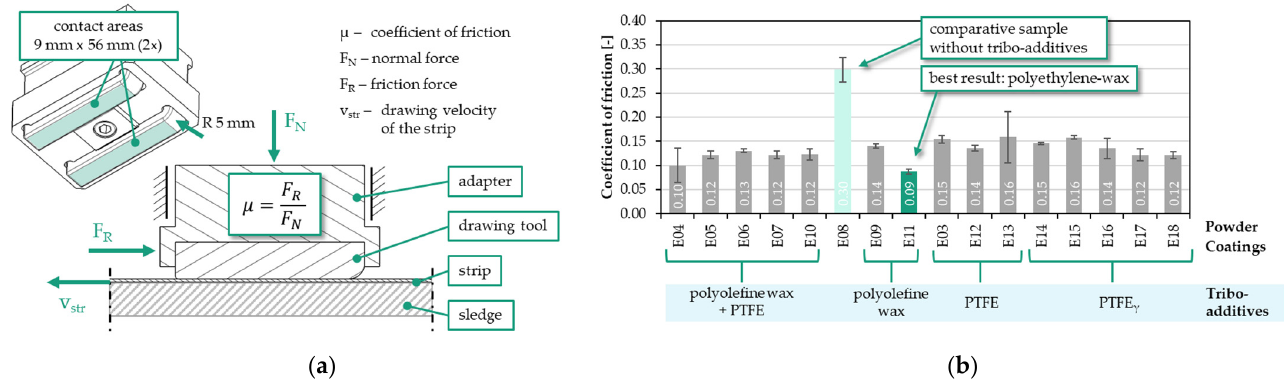
Figure 6. Flat strip drawing test for determination of the coefficient of friction: ( a ) test principal; ( b ) results without lubrication.